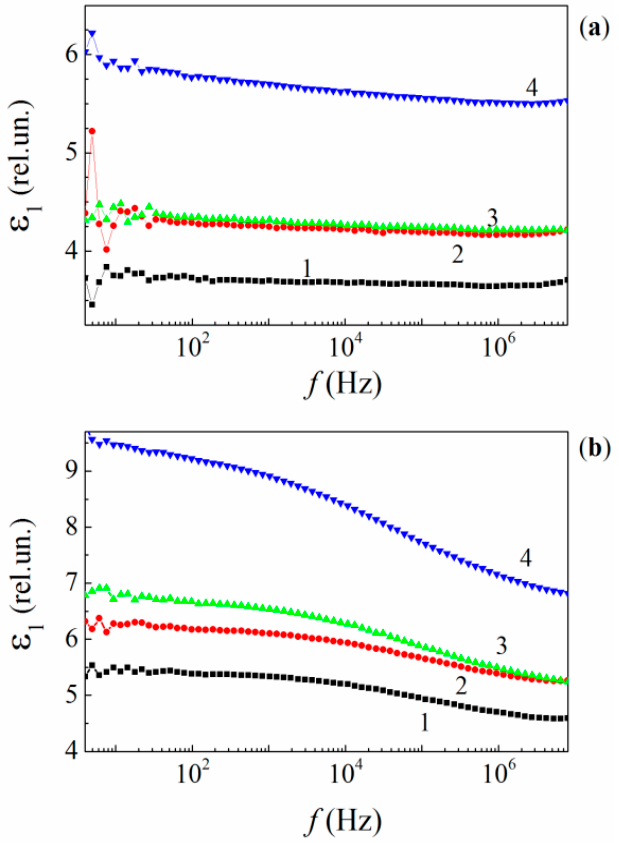
Figure 10. Frequency dependences of the relative dielectric permittivity for the neat epoxy (1) and MLG composites of 1% (2), 2% (3), and 5% (4) MLGs at 95 К ( а ) and 300 K ( b ). MLG composites of 1% (2), 2% (3), and 5% (4) MLGs at 95 K ( a ) and 300 K ( b